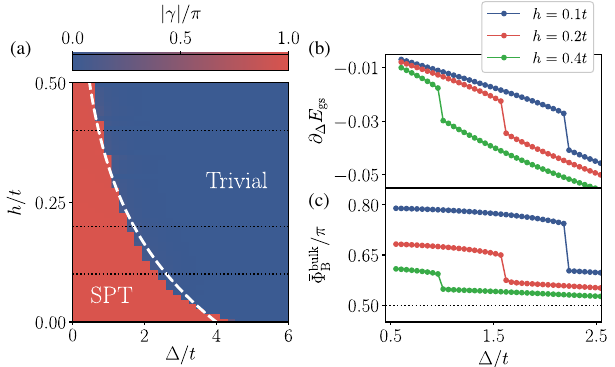
FIG. 4. Topological phase transitions. (a) Contour plot of the many-body Berry phase, which allows differentiating between the SPT with γ ¼ π and the trivial band insulator (TBI) with γ ¼ 0 . The dashed line is obtained by fitting the critical points to an exponential (see main text). (b) First derivative of the ground- ( E Δ − E Δ ) = ð Δ − Δ state energy ∂ Δ E 1 Þ 2 Þ 1 2 Þ with re- gs ¼ gs ð gs ð spect to the imbalance Δ =t for different values of h=t . (c) Average Ising flux Φ bulk B as a function of the imbalance Δ =t . The calculations were performed directly in the thermodynamic limit for a half-filled